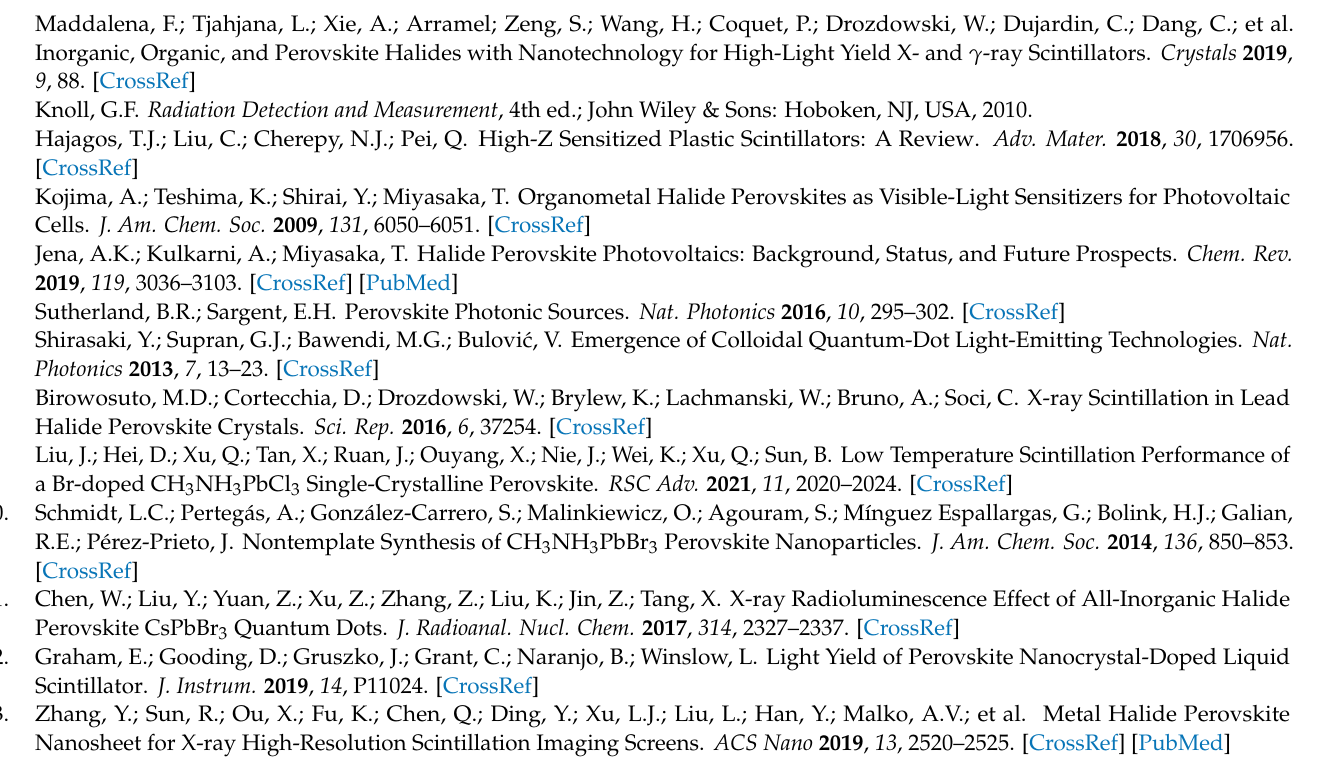
Table S2: Microwave digestion results for FAPbBr 3 /EJ-290 composites, and for FAPbBr 3 /PMMA